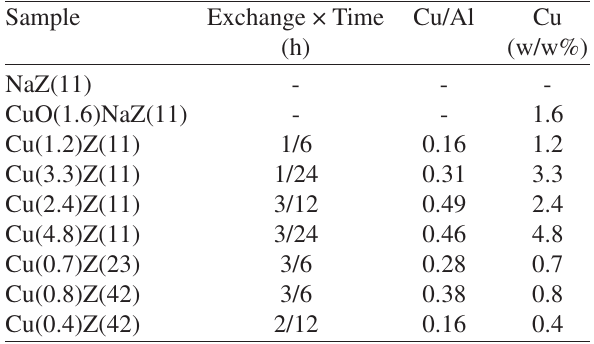
Table 1. Characteristics of the prepared Cu/ZSM-5 catalysts.